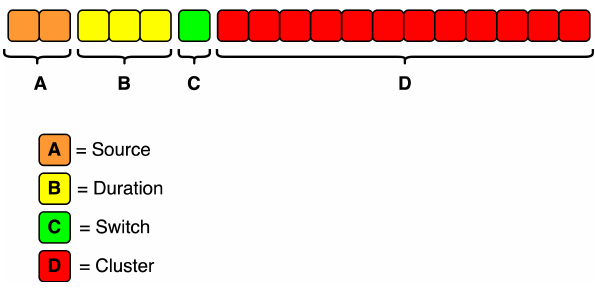
Figure 18. Coding scheme for representing a cluster of musical notes.